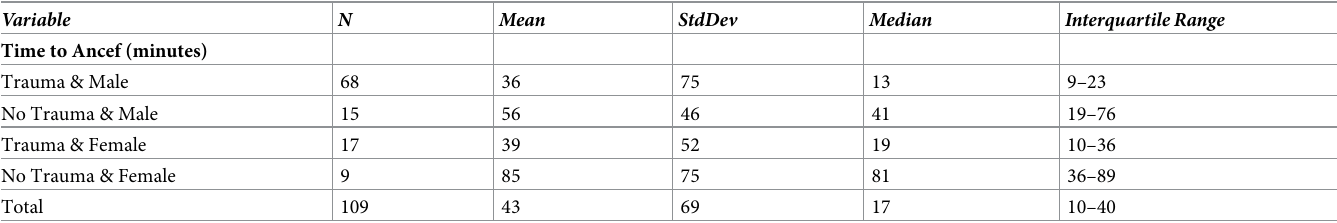
Table 4. Time to cefazolin partitioned by trauma team activation and gender.